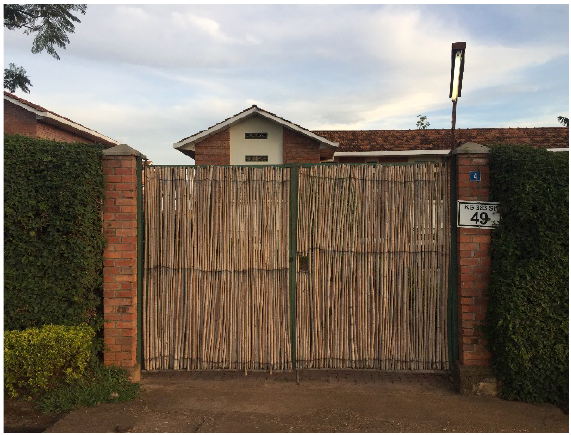
Figure 42. Typical gate. Photograph by Manlio Michieletto.